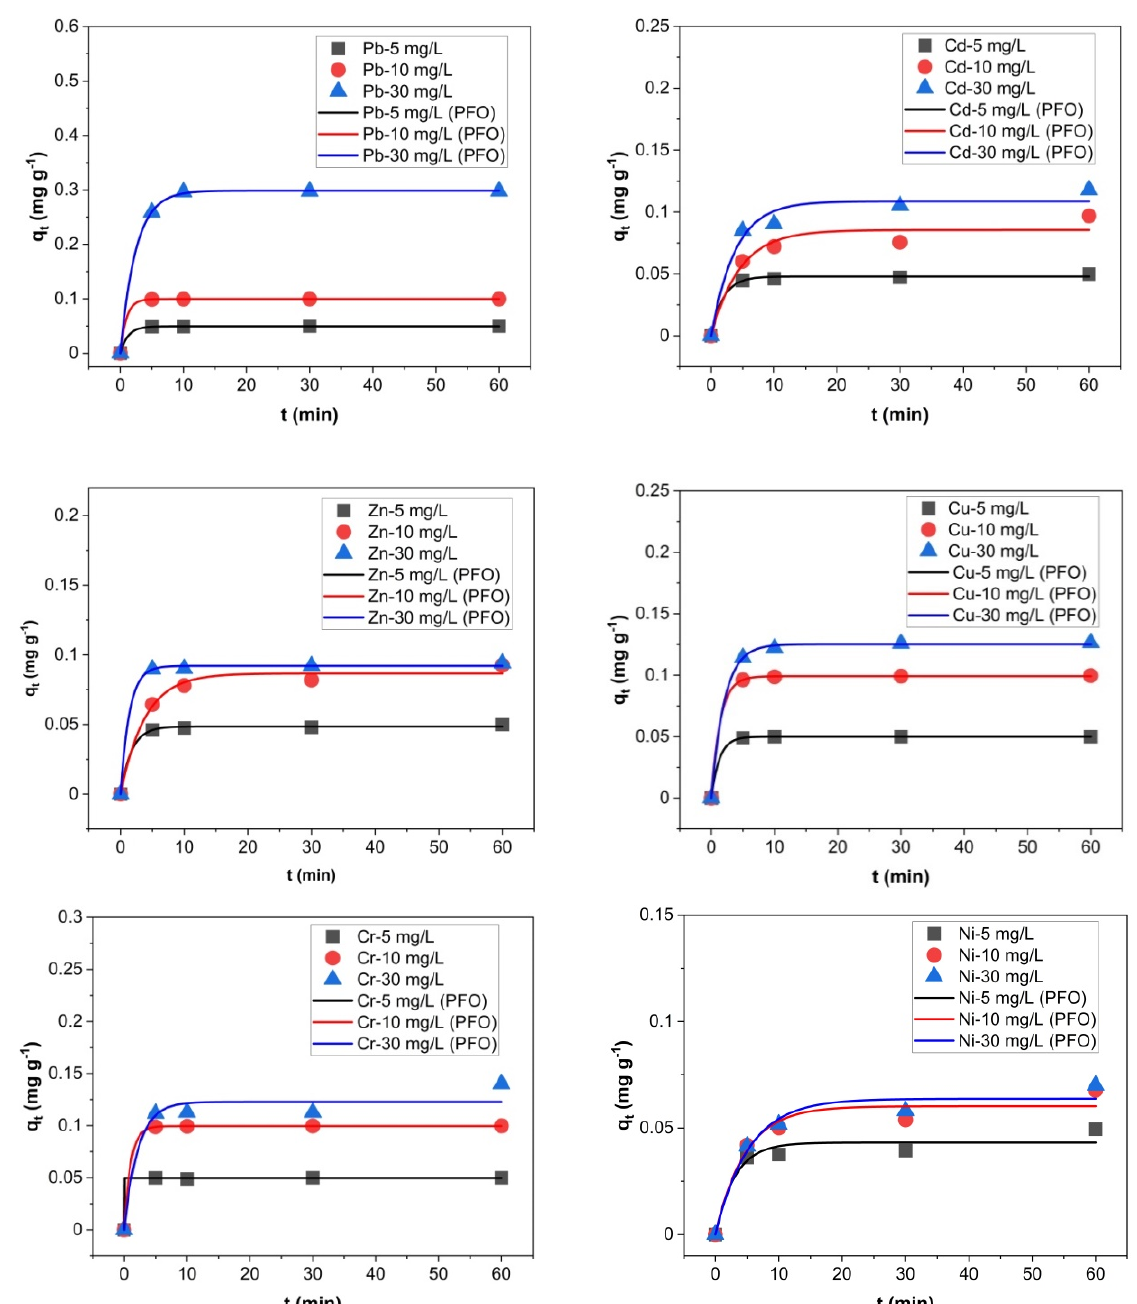
Figure 9. Nonlinear fitting of PFO for Pb, Cd, Zn, Cu, Cr and Ni ions sorption onto zeolite with a 0–0.05 mm particle size thermally treated at 200 °C.